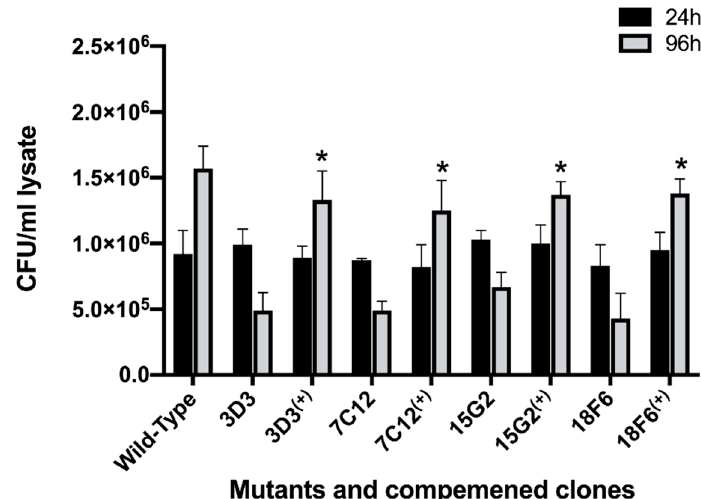
Figure 7. The growth rate of complemented MAP clones within macrophages. RAW 264.7 monolayers were infected with the wild type, the gene knockout mutants or complemented clones as described in materials and methods. The colony forming units of surviving intracellular bacteria were determined at one and four days post-infection. Data represent the mean ± SD of three independent experiments each completed in triplicate. *, p < 0.05 between the complemented clone and mutant at the corresponding time point.